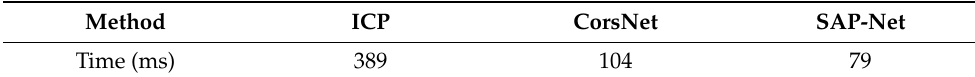
Table 8. Computational efficiency.